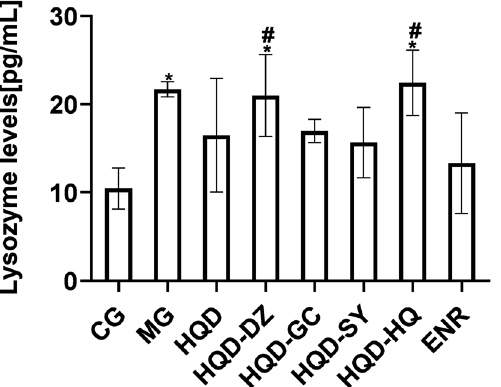
Figure 4. Lysozyme level of chicks was shown in the figure. Data are expressed as mean ± SEM. Statistical significance: * p < 0.05 versus model group, # p < 0.05 versus HQD group. CG, Control group; MG, Model group; DZ, jujube, Ziziphus jujuba ; HQ, Chinese skullcap, Scutellaria baicalensis ; GC, licorice, Glycyrrhiza glabra ; SY, white peony root, Paeoniae radix alba ; HQD, decoction consists of DZ, HQ, GC and SY; HQD-DZ, HQD absent of DZ; HQD-GC, HQD absent of GC; HQD-SY, HQD absent of SY; HQD-HQ, HQD absent of HQ; ENR, Enrofloxacin group. (The dosage of Chinese medicine was 500